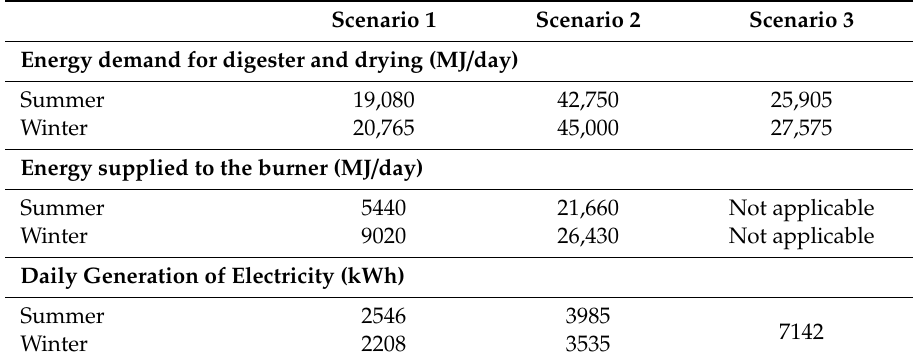
Table 4. Energy demand and electricity production from biofuel valorization by the use of a CHP